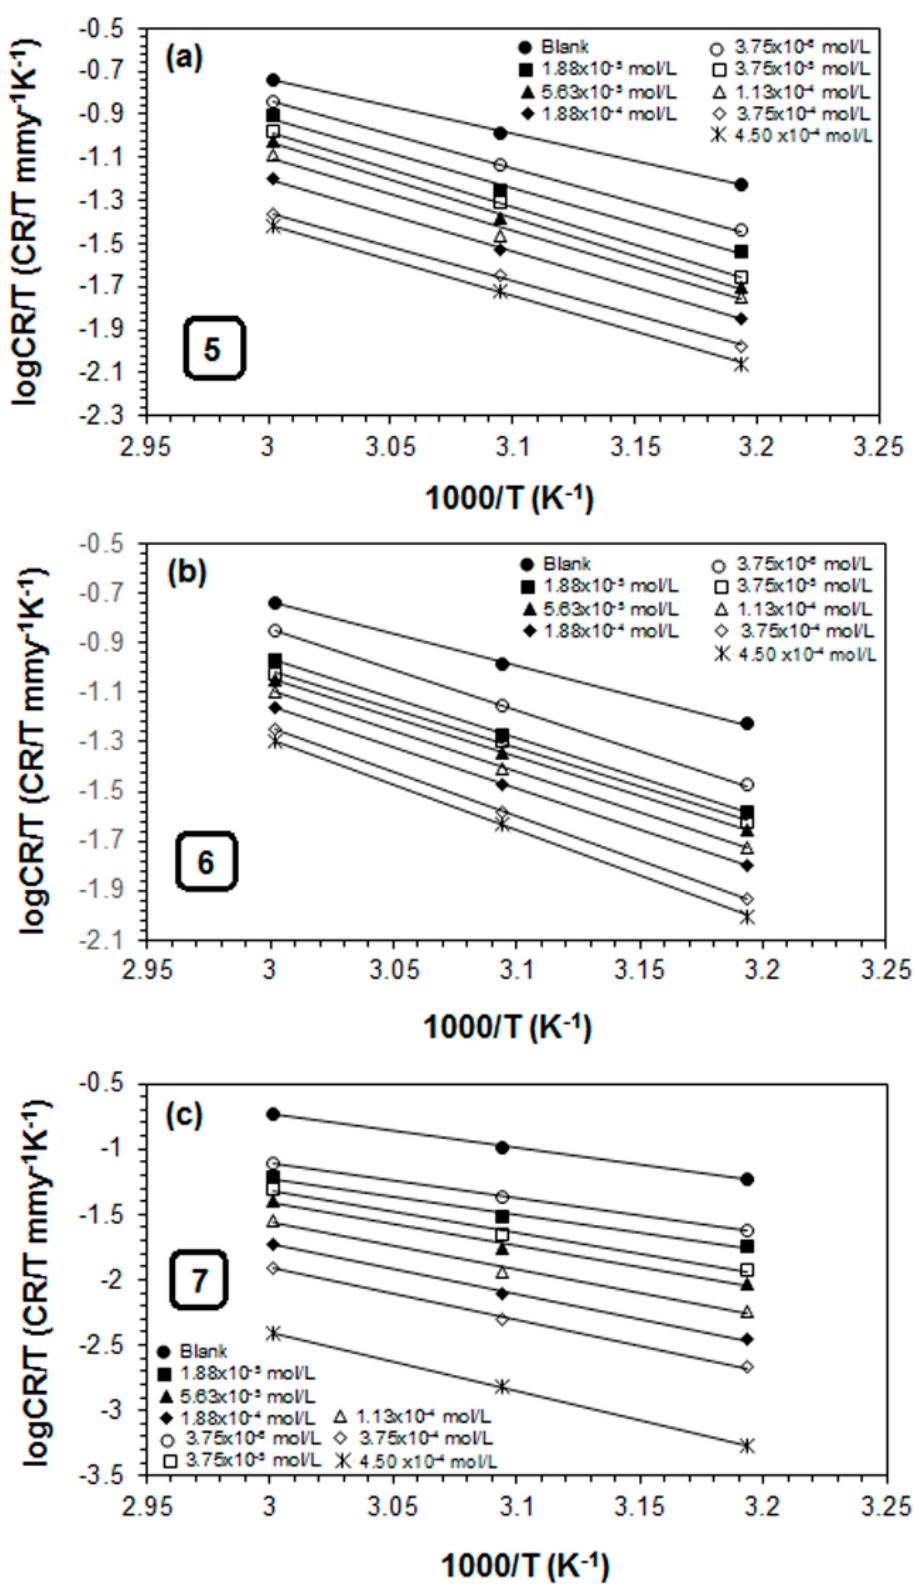
Figure 4. Transition state plot of log CR / T versus 1000 / T for mild steel in 1 M HCl solution at di ff erent concentrations: ( a ) 5 , ( b ) 6 , and ( c ) 7